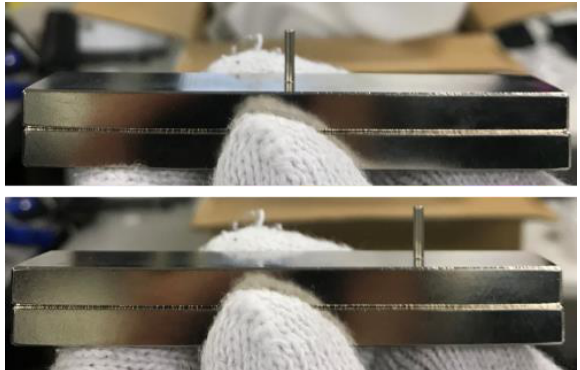
Figure 9. Pin magnet positioned at center and peripheral regions of rectangular magnet. The photographs indicate that the pin can remain vertical because of vertical magnetic